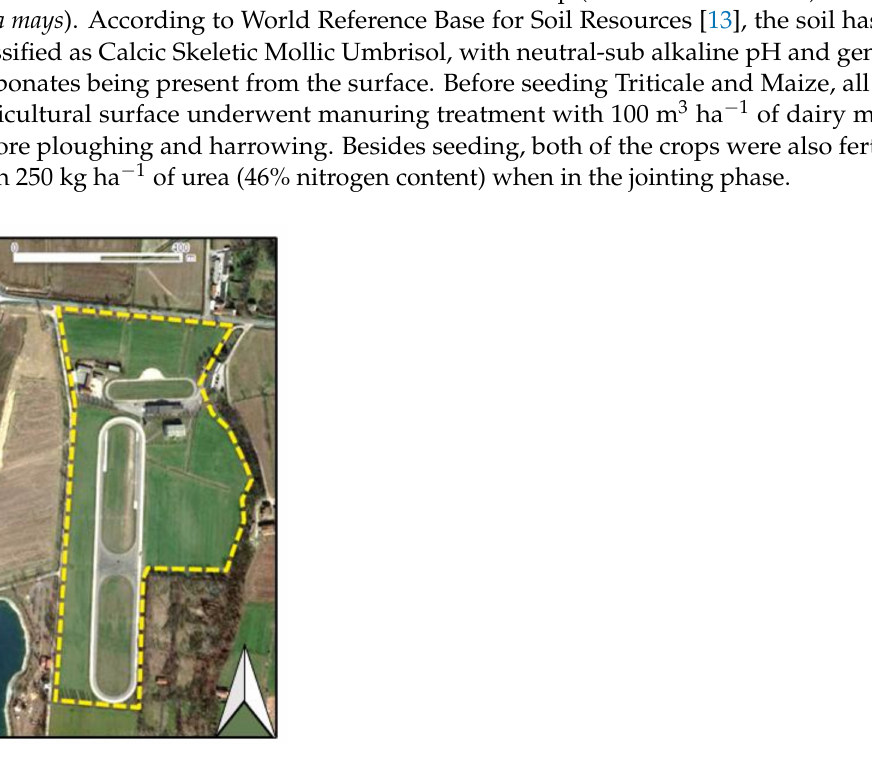
Figure 1. An aerial view of the experimental site (cultivated fields and test tracks): the closed dashed line represents the experimental site main